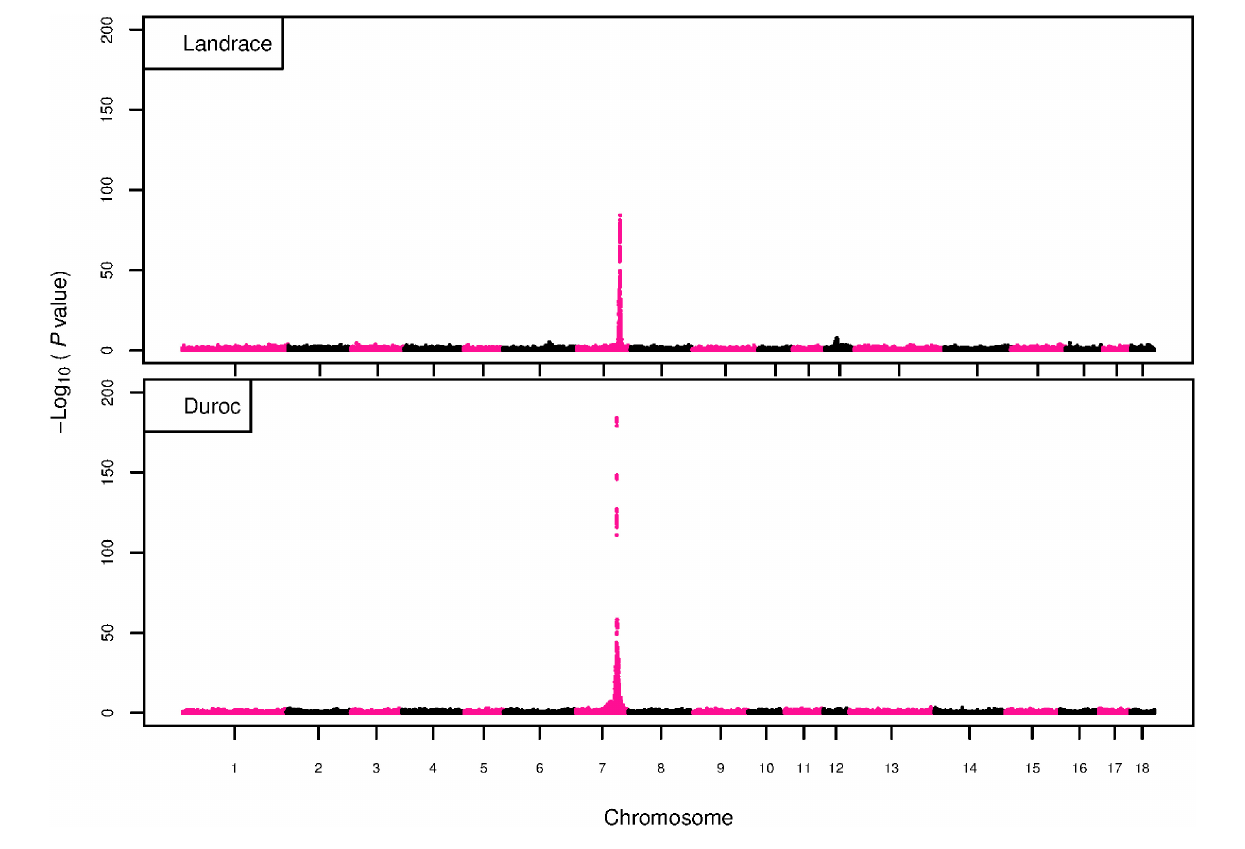
Frontiers in Genetics |